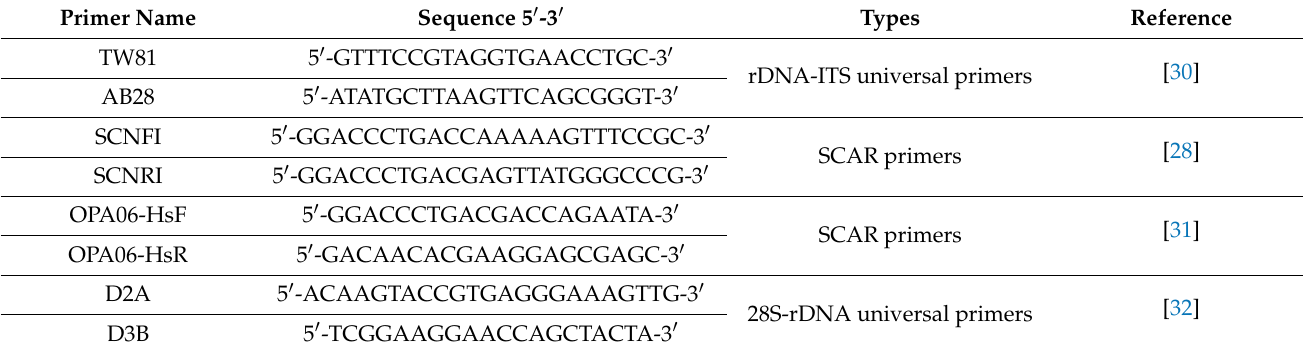
Table 1. Codes and sequences of primers used in this